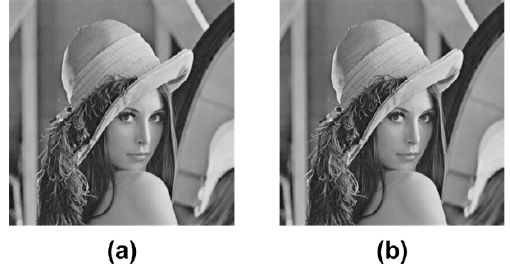
Figure 9. The test image Lena: ( a ) Original; and ( b ) directly decrypted image.